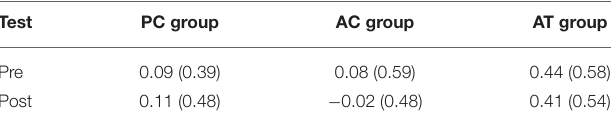
TABLE 5 | Interference produced by visual distractors on the Corsi span (trials with visual distractors subtracted from trials without distractors), as measured at pre- and post-test in old adults.